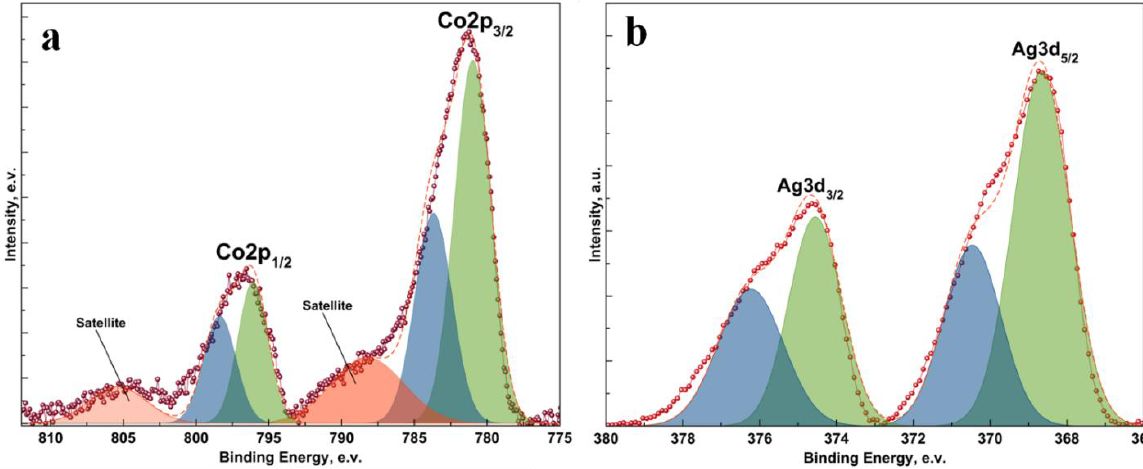
Figure 2. High-resolution deconvoluted X-ray photoelectron spectroscopy (XPS) analysis of ( a ) Co ( b ) Ag, on CN surface.